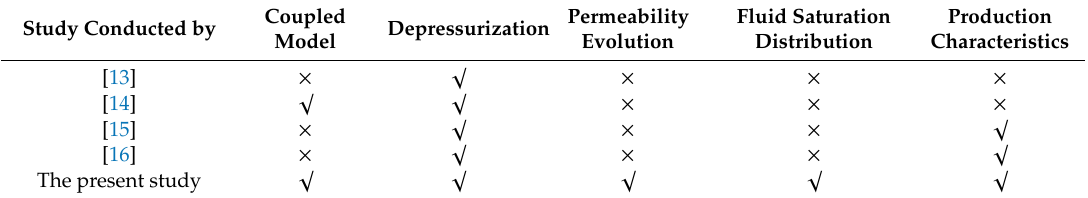
Figure 15. Evolution of water saturation at the three couples of points along the dip.